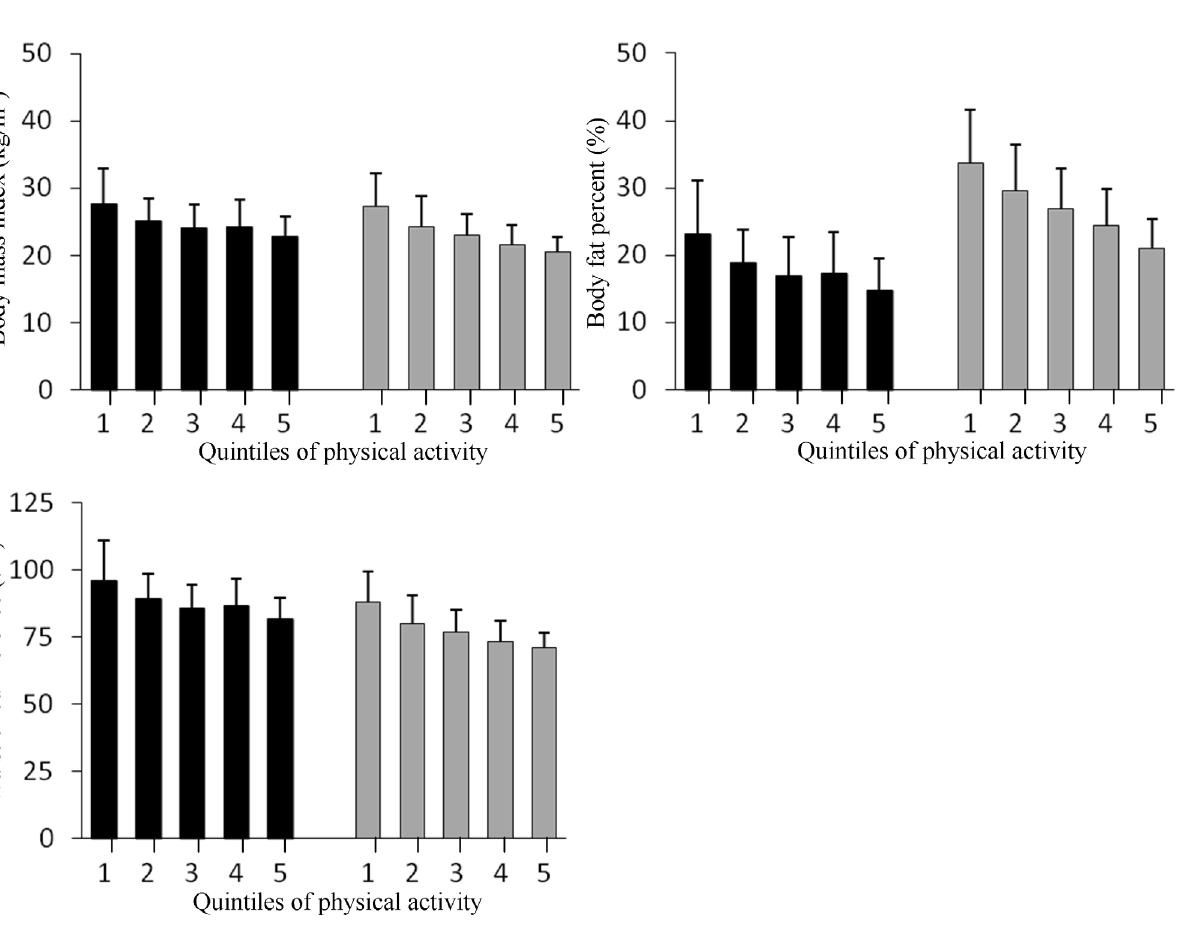
Fig 1. Body composition and physical activity. Mean and standard deviations of body mass index (kg/m 2 ), waist circumference and body fat percentage according to physical activity quintiles of total volume (MET-hours) in men (black bars) and women (gray bars). MET-hours ranges for the quintiles were: 19.92 – 33.22, 33.25 – 36.39, 36.39 – 38.87, 38.90 – 42.77 and 42.79 – 60.34, respectively. Inverse associations between volume and body composition measures, adjusted for age, smoking and educational attainment were statistically significant in both genders ( P for trend < 0.001 for